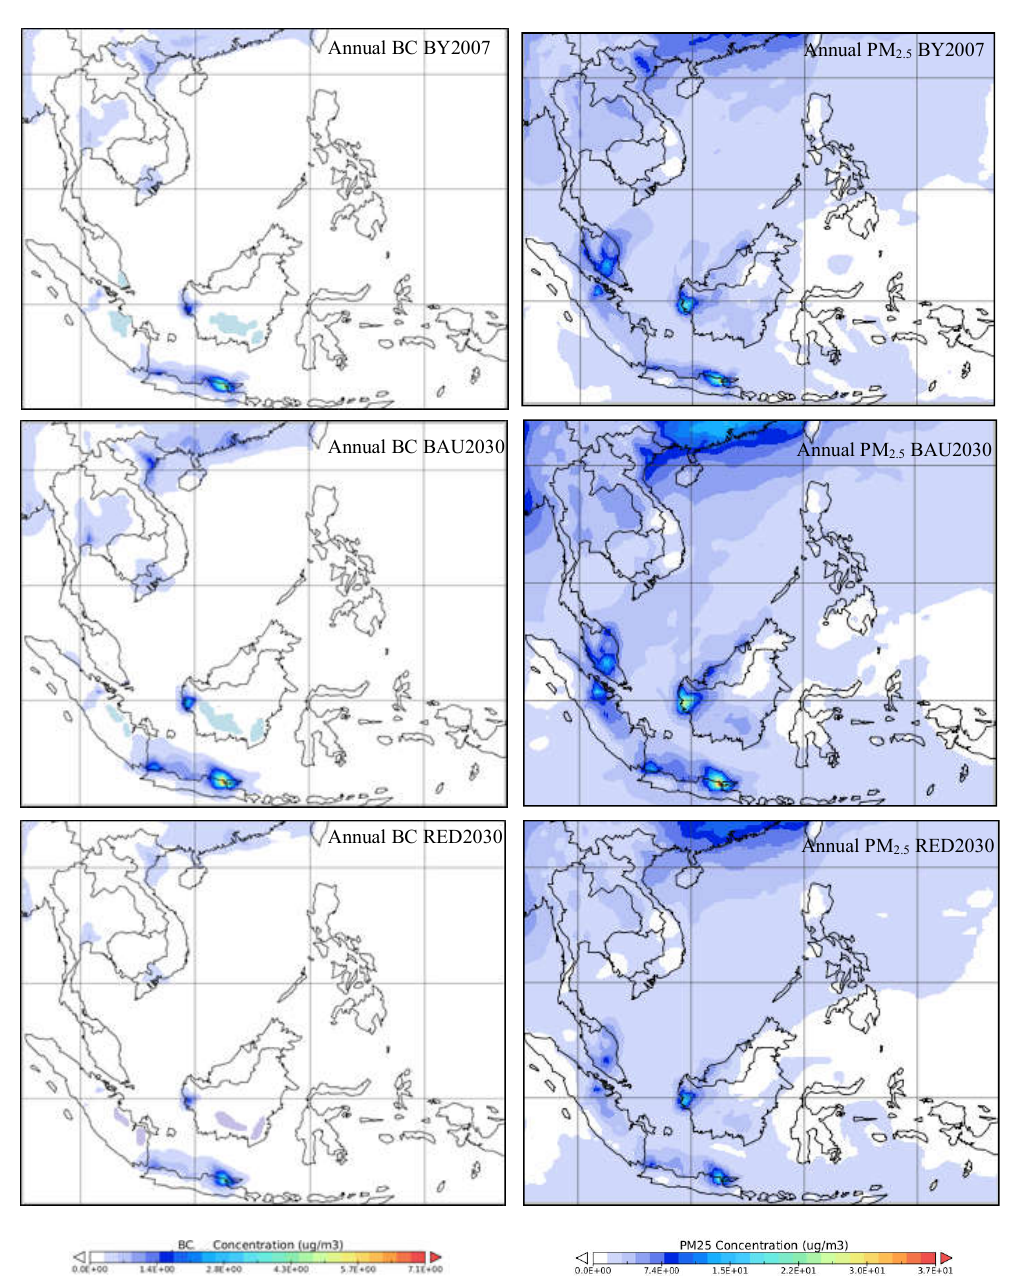
Figure 2. Simulated annual average concentrations of BC and PM 2 . 5 for BY2007, BAU2030 and RED2030 in µgm − 3 .